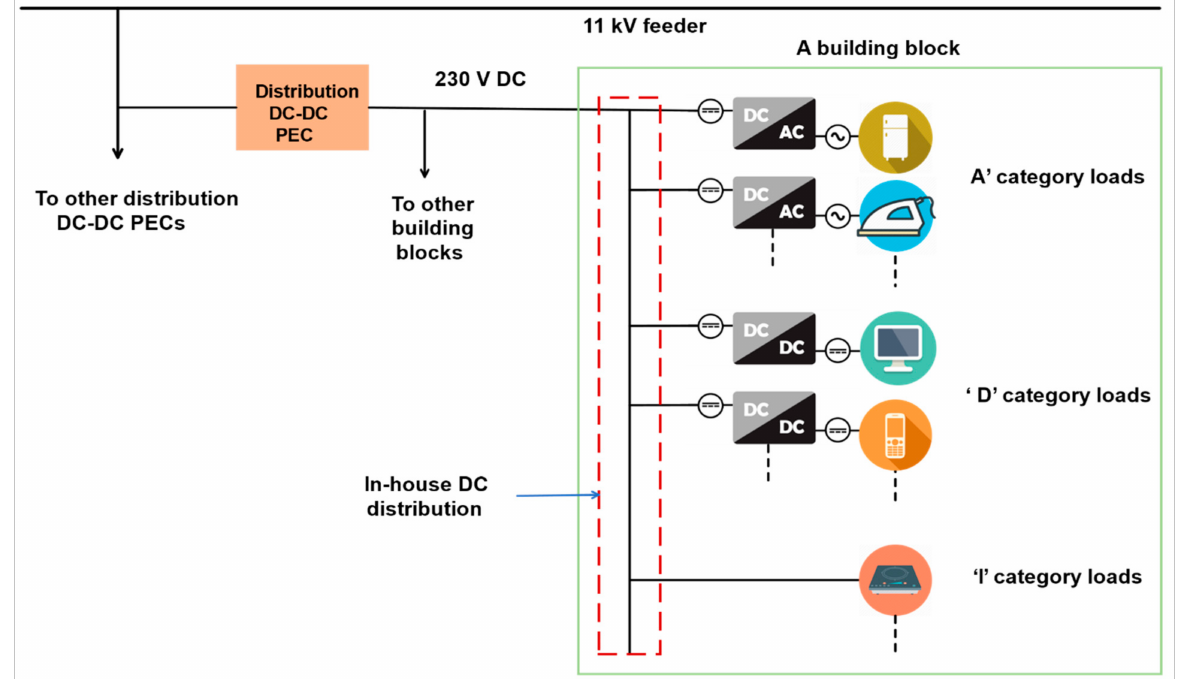
Figure 1. Load model of a typical community distribution system